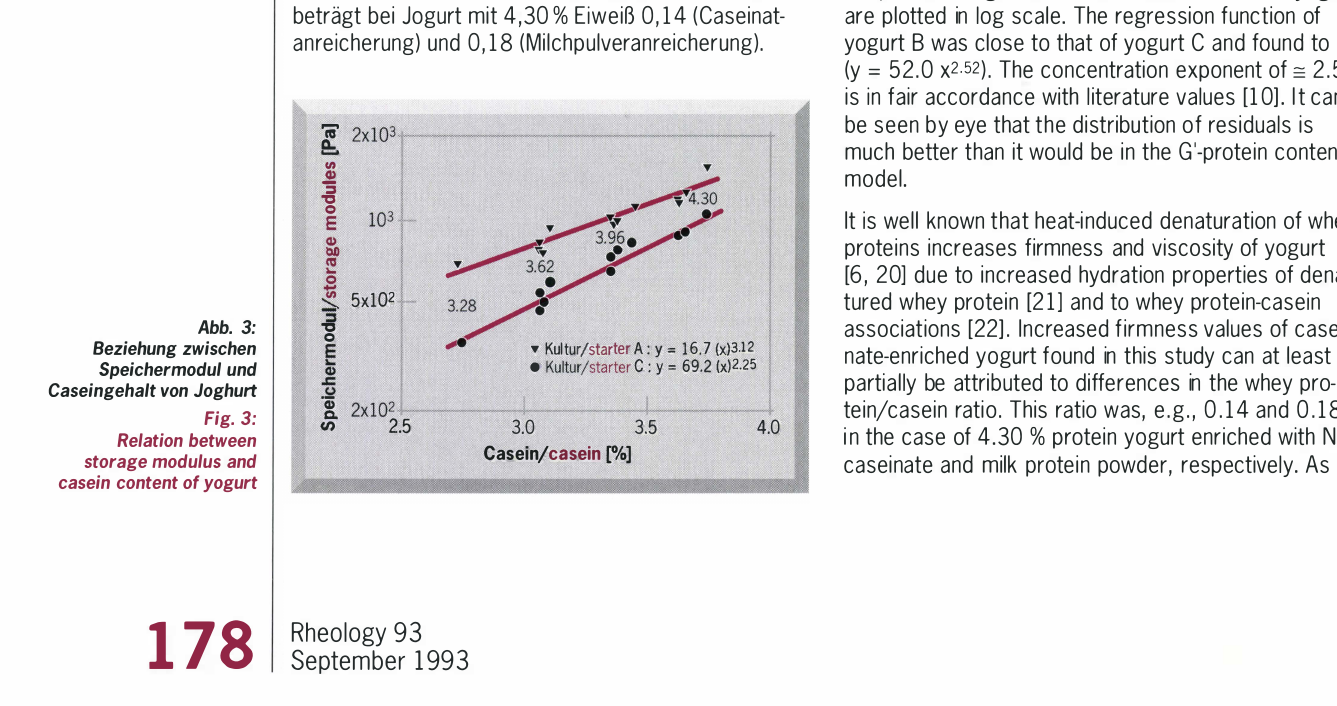
em Auge abschatzen.